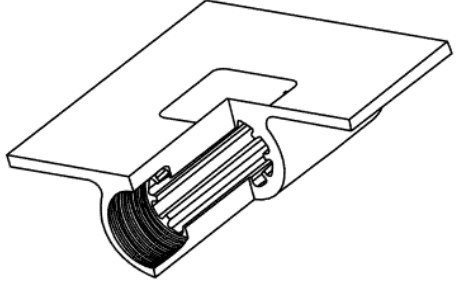
Figure 11. Isometric view of heat receiver tested in [94]. Reprinted with permission from Ref. [94]. 2015, Elsevier.